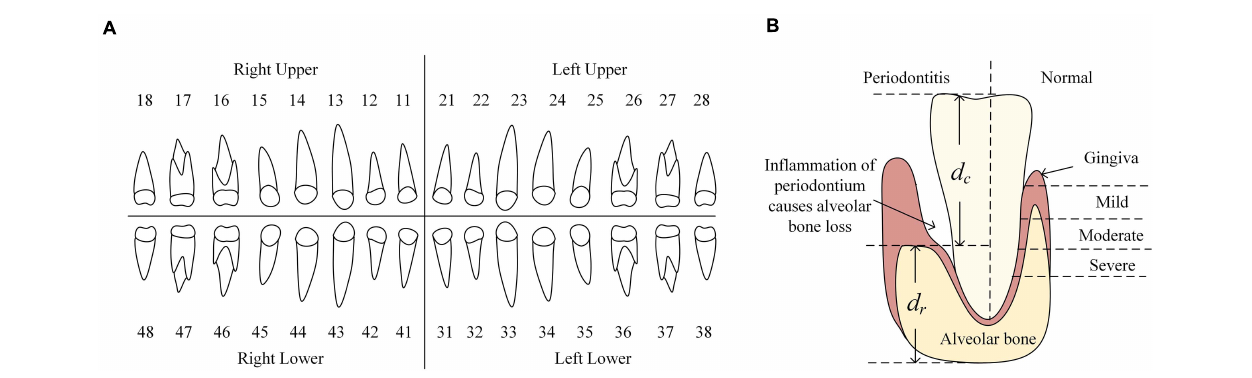
FIGURE 1 | (A) FDI numbering system. It divides all teeth into four quadrants where teeth are labeled as 11–18, 21–28, 31–38, 41–48, respectively. (B) The left of tooth shows the appearance of periodontitis and the representation of ABL. d c represents the ABL and d c + d r is used for normalize the ABL. Thus, each tooth has its ABL representation calculated as d c /(d c + d r ). The right of tooth shows the appearance of a normal tooth. Different severities of alveolar bone loss reflect the severities of periodontitis (normal, mild, moderate and severe